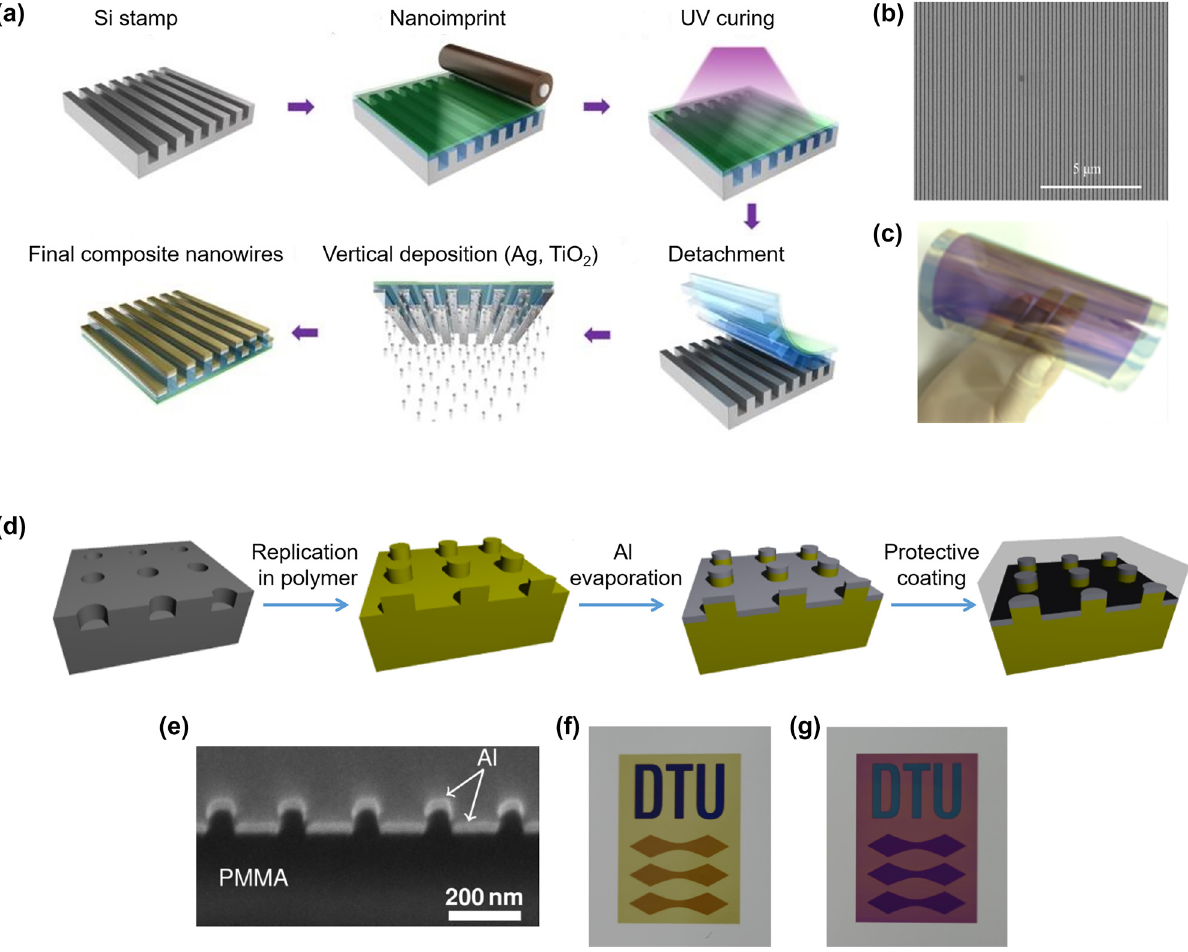
Figure 24: Nanoimprint lithography for fabricating subwavelength nanostructure array based structural colors. (a) Fabrication process of large-scale, flexible, and polarization-dependent structural colors with composite nanowire structures. (b) and (c) SEM and photo of a fabricated sample. Modified with permission [256]. Copyright 2018, American Chemical Society. (d) Fabrication scheme of 2D plasmonic nanostructures. (e) Cross-sectional SEM image of a fabricated sample, showing the PMMA polymer pillar array covered by a metallic Al layer. (f) and (g) Optical images of a fabricated sample without (f) and with (g) the protective coating (Ormocomp, Micro resist technology GmbH). Modified with permission [257]. Copyright 2014, American Chemical